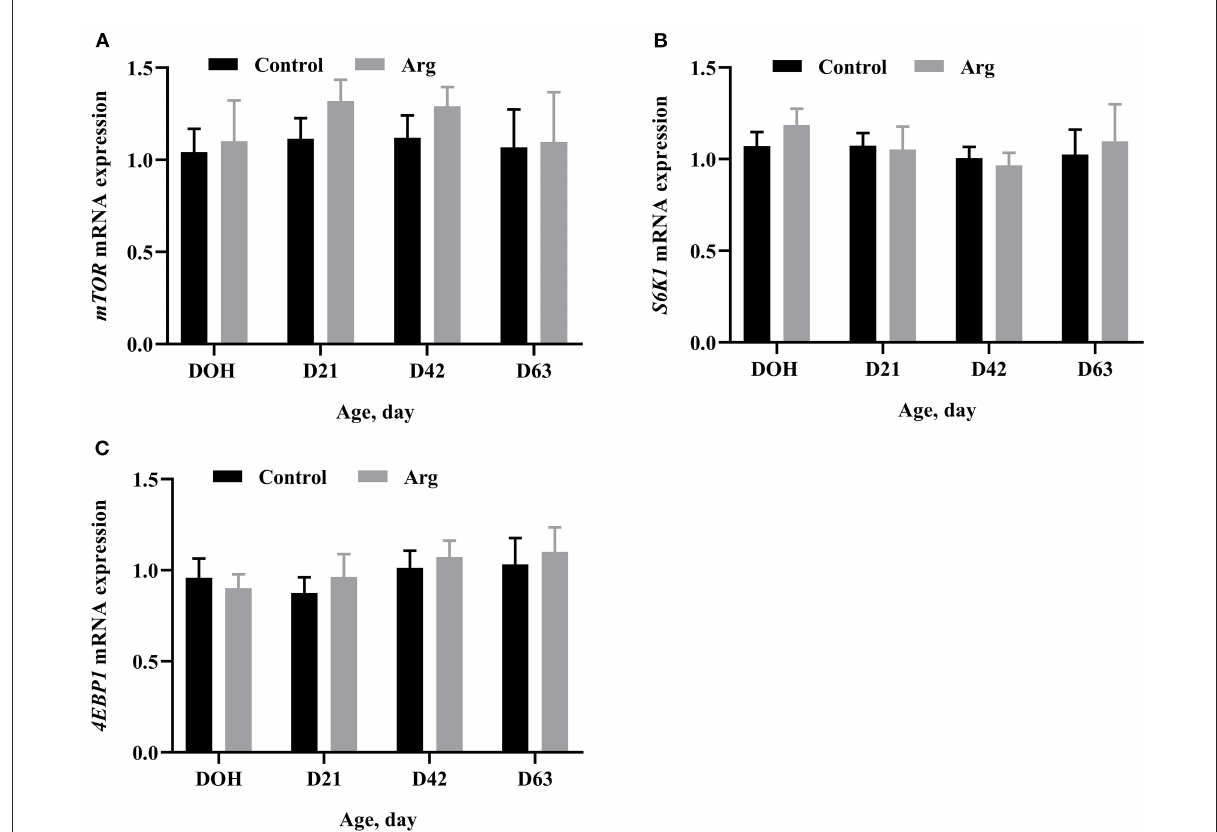
FIGURE2 Effects of in ovo feeding of L-arginine on gene mRNA expression related to the mTOR signaling pathway on DOH, D21, D42, and D63 post-hatch in slow-growing chickens. (A) mTOR , mammalian target of rapamycin; (B) S6K1 , ribosomal protein S6 kinase 1; (C) 4EBP1 , eIF4E-binding protein 1. DOH, day of hatching; D21, day 21; D42, day 42; D63, day 63. Control, non-injected group; Arg, 1% L-arginine-injected group. SEM, standard error of the mean. Values are means with n = 8 per treatment. Different superscripts indicate significant differences between the two groups ( P <